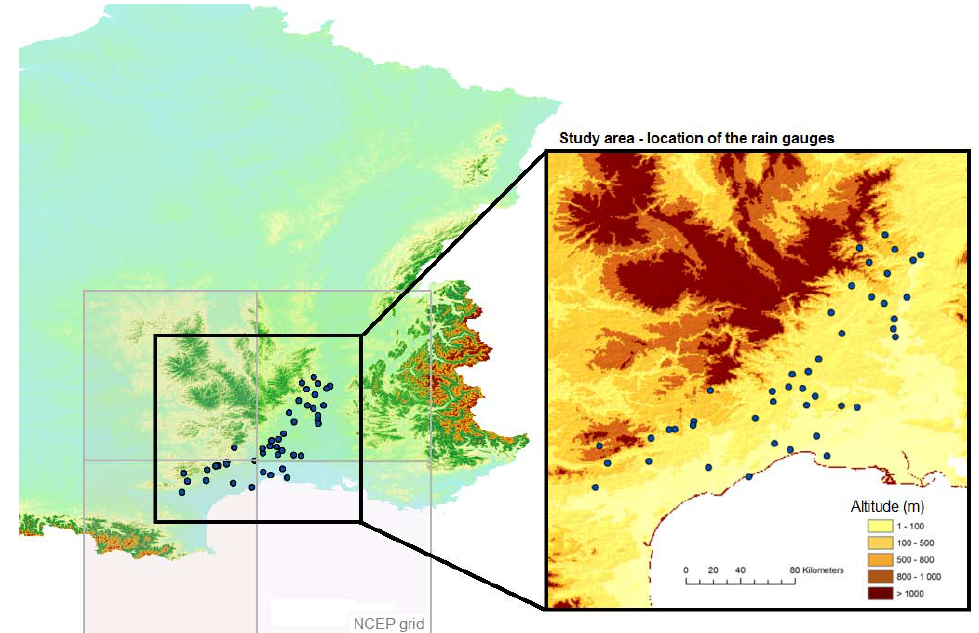
Fig. 1. Location of the 44 rain gauges in Southern